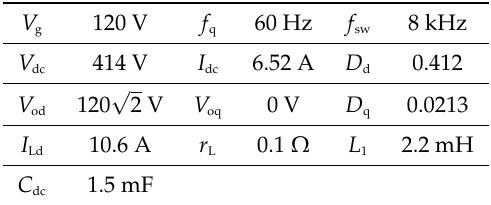
Table 1. Parameters of small-scale